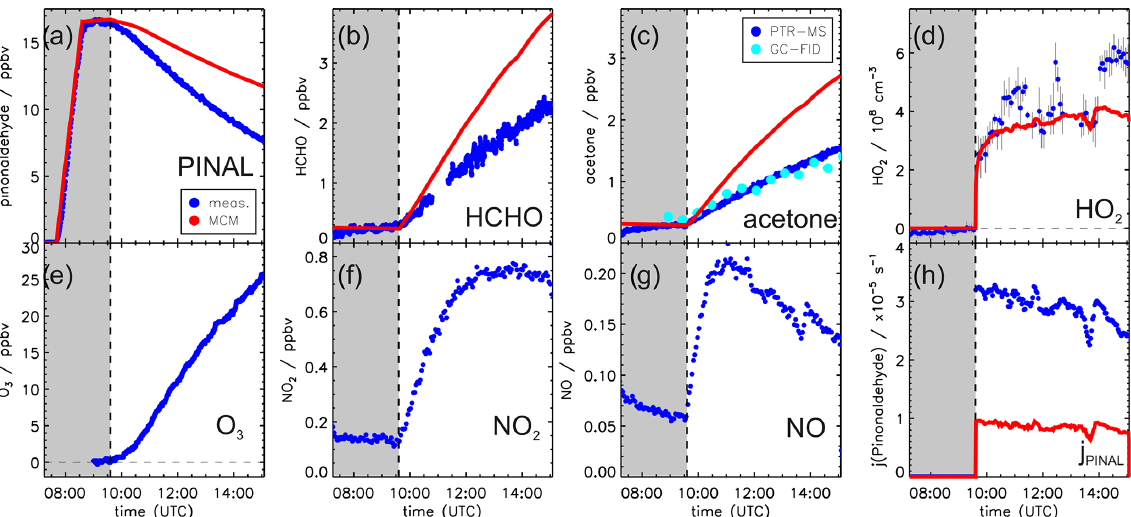
Figure 2. Measured and modeled trace gas concentrations and photolysis frequencies during photooxidation of pinonaldehyde in the presence of an OH scavenger. Pinonaldehyde is removed by photolysis only. Measured O 3 , NO 2 and NO were used as constraints for the model. See the text for details of the pinonaldehyde photolysis frequency ( h ). Grey-shaded areas indicate times when the chamber roof was closed.